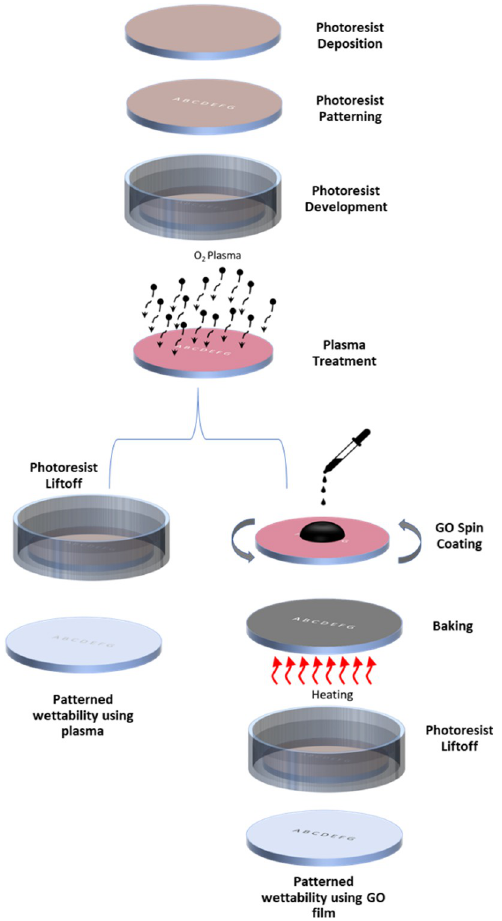
Fig 1. Schematic diagram illustrating the fabrication steps involved in patterning the COC wafer’s surface wettability using plasma and GO film.